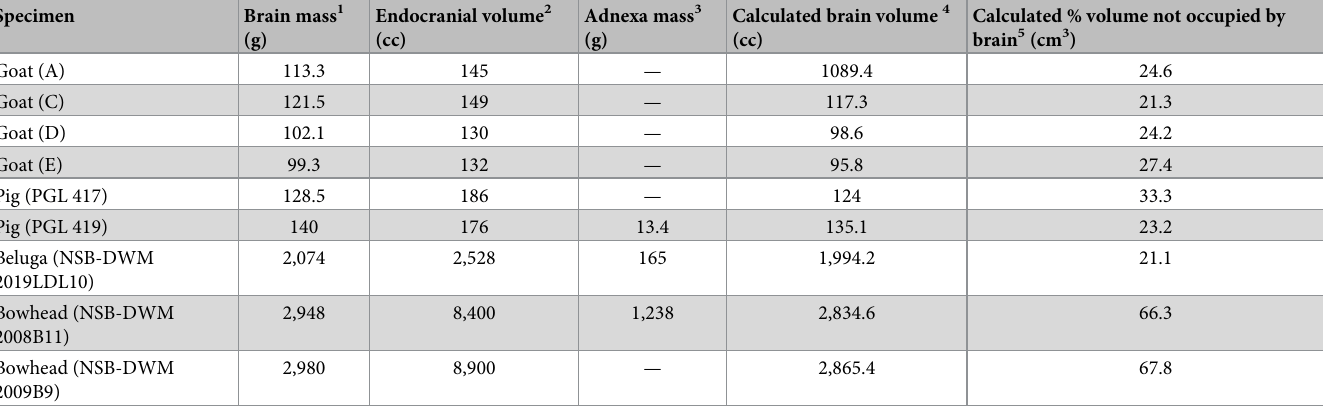
Table 1. Brain mass, endocranial volume and adnexa mass in terrestrial artiodactyls and cetaceans.